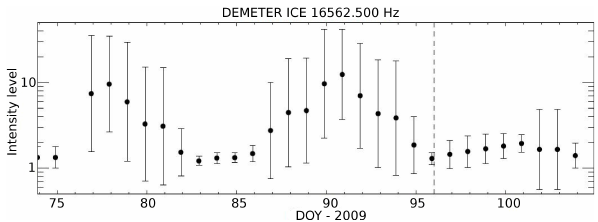
Fig. 2. Variation of the DEMETER observed signal at the frequency of 16652.5Hz (the closest frequency to the German transmitter sig- nal 16560Hz) versus the day of the year 2009 (from 15 March to 11 April 2009). The day of the EQs is indicated by a vertical dashed line.